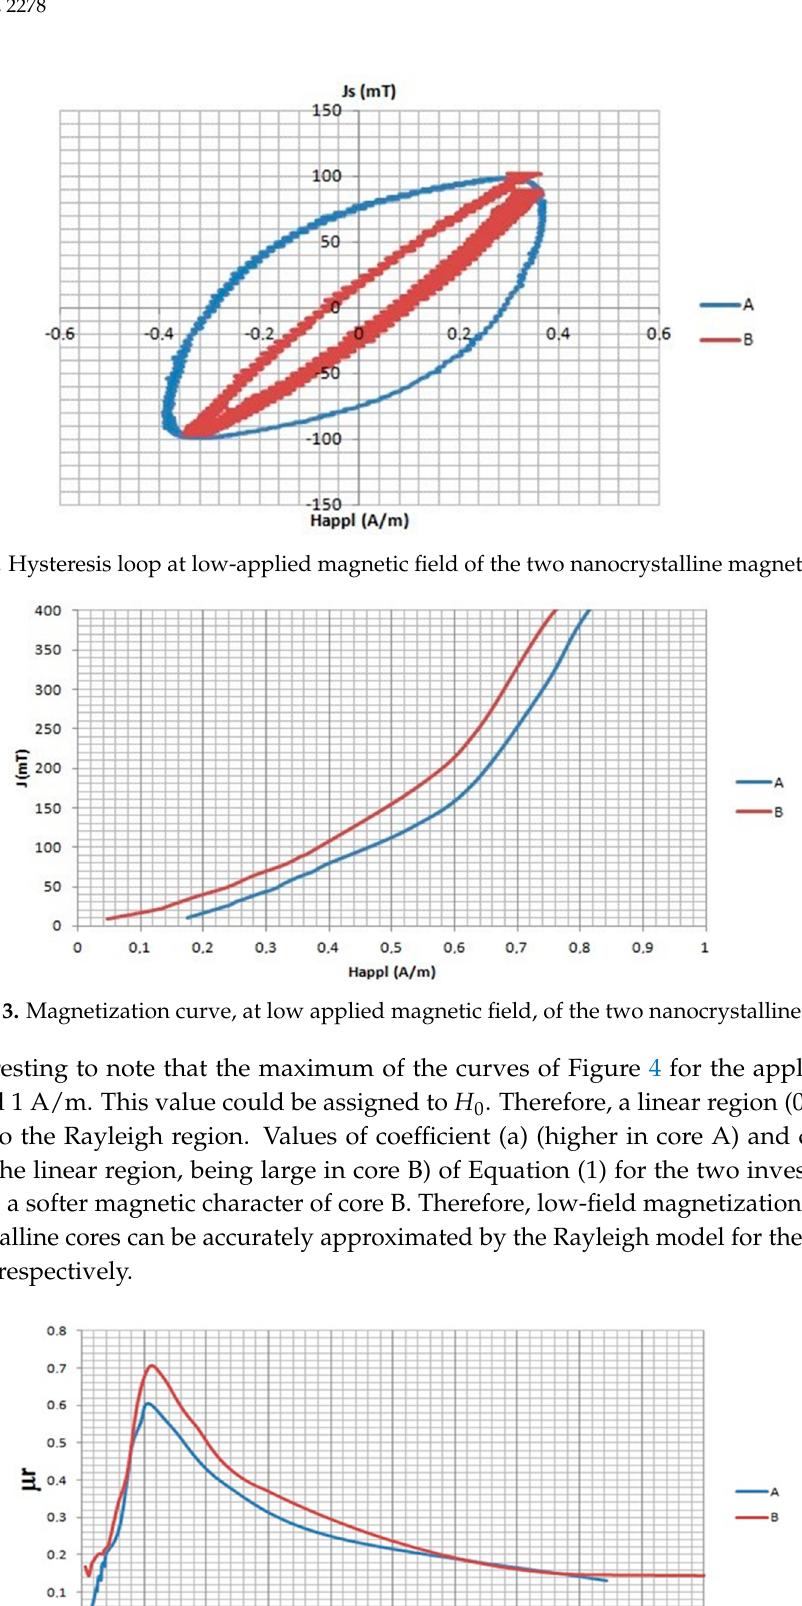
Figure 4. Relative permeability µ r = J/H 0 vs. the applied external field, H appl , for the two nanocrystalline samples. The virgin magnetization curves as a function of the external magnetic field are shown in Figure 5. Note that the approach to magnetic saturation is reached by core A (less volume of nanocrystals) with a large applied magnetic field as compared to core B.